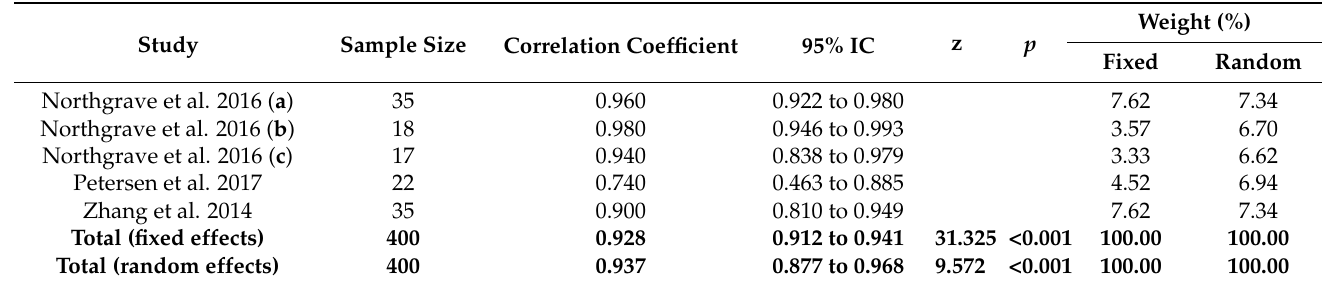
Table 2. Test-retest reliability meta-analysis (95% CI) for FTSST.